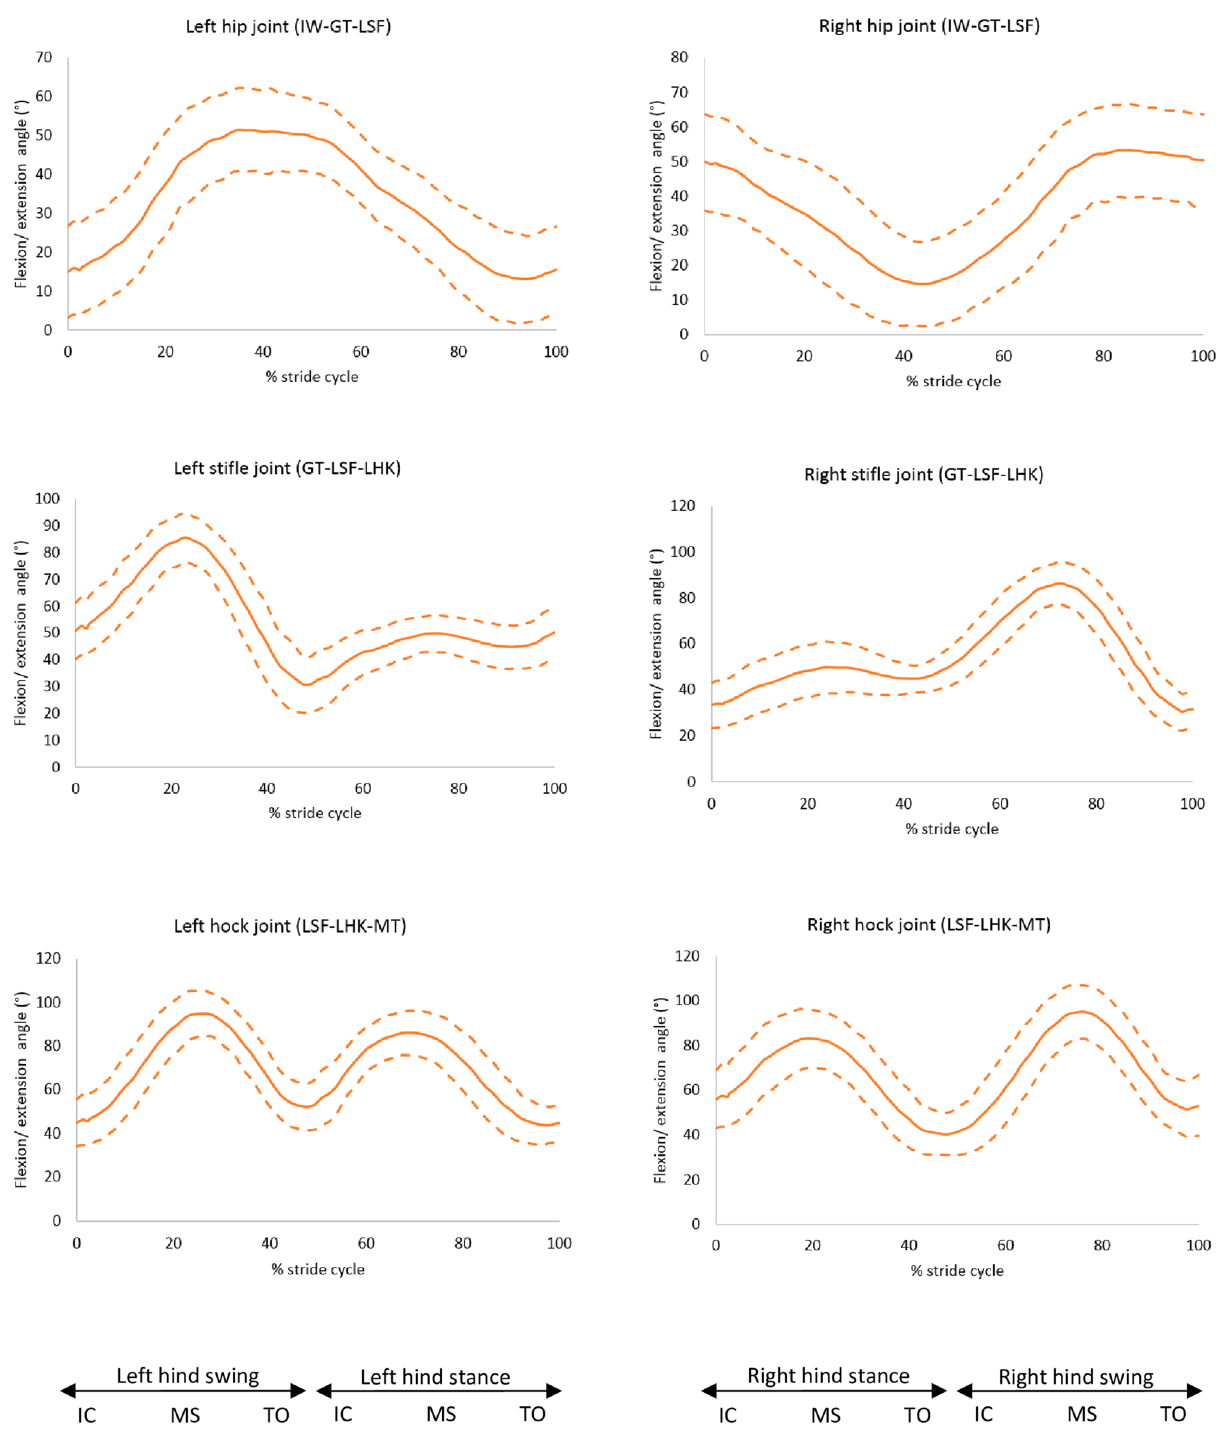
Figure 8. Flexion (positive) and extension (negative) angles for the hindlimb joints, mean of 30 GSDs (solid line) and showing one standard deviation from the mean (dashed lines). Graphs are plotted for one stride cycle, showing initial contact (IC), Mid Stance (MS) and Toe Off (TO) for the left and right diagonals. Between brackets: marker names (Supplementary material 3, 16.7°) for the right hip. During the swing phase, the hips were externally rotated, as shown in Fig. 9. The hocks were shown to be externally rotated throughout the stride cycle, where the mean maximum external rotation for the left hock in all the GSDs was 40.4° (SD: 10.3°) and for the right hock was 39.7° (SD: 9.1°) (Fig. 11 and S7). The slope of the back had no significant effect on the internal or external rotation of the back during trot. The thoraco-lumbar and lumbo-sacral regions of the back were axially rotated to the right side of the dog (positive)